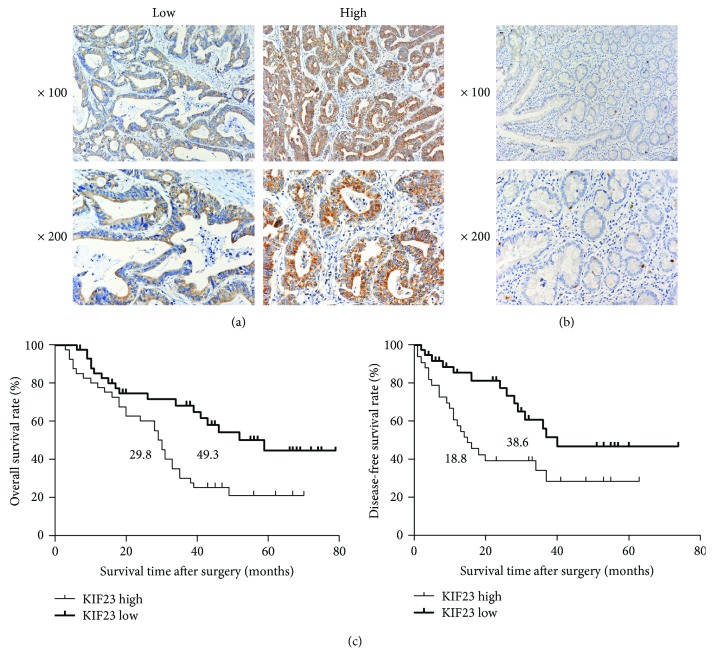
The expression level of KIF23 in tumor tissues was associated with the prognosis of patients who have gastric cancer. (a) Immunohistochemistry analysis of expression of KIF23 protein in gastric cancer tissues (×100 and ×200 magnifications, respectively). (b) Immunohistochemistry analysis of expression of KIF23 protein in the adjacent tissues (×100 and ×200 magnifications, respectively). (c) The difference analysis of the overall survival rate and disease-free survival rate between the low- and high-KIF23 expression groups: the median survival period of OS in the low- and high-KIF23 expression groups was 29.8 and 49.3 months, respectively, and the median survival period of DFS in the low- and high-KIF23 expression groups was 18.8 and 38.6 months, respectively.